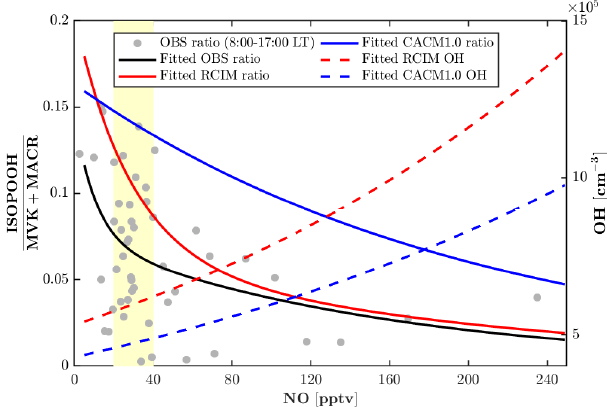
Figure 6. Daytime (08:00–17:00 local time) measurement-based and modeled ratio of ISOPOOH (isoprene hydroxy hydroperox- ides) to MVK + MACR (methyl vinyl ketone + methacrolein). Measurement-based ratios of ISOPOOH to MVK + MACR are from 23–27 July 2016 (Grey dots). The fitted exponential curve is for measurement-based ratios (black line), RCIM ratios (red line), CACM1.0 ratios (blue line), RCIM OH concentrations (red dash line), and CACM1.0 OH concentrations (blue dash line). The yel- low patch denotes the most frequently observed nitric oxide (NO) levels (20–40pptv) during the period of 23–27 July